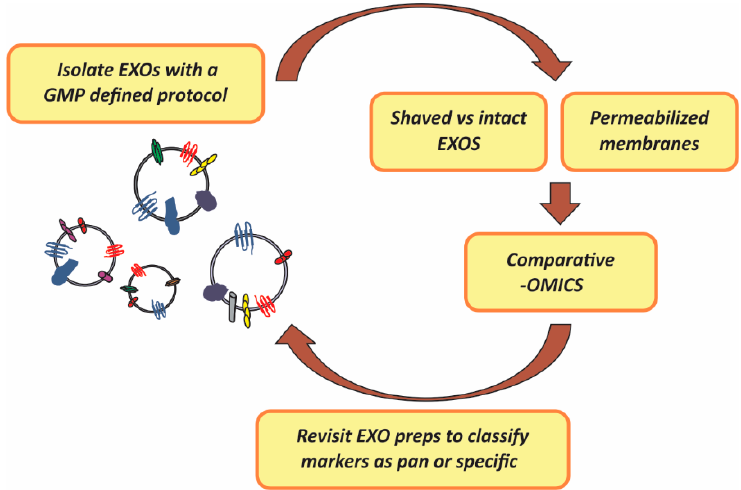
Figure 1. Strategy proposed for the identification of EXOs (exosomes) pan (general) and specific surface markers to serve as classification and functional subtyping criteria. GMP (Good Manufacturing Practices); preps (preparations); -OMICs (proteomic, lipidomic and transcriptomic analysis).